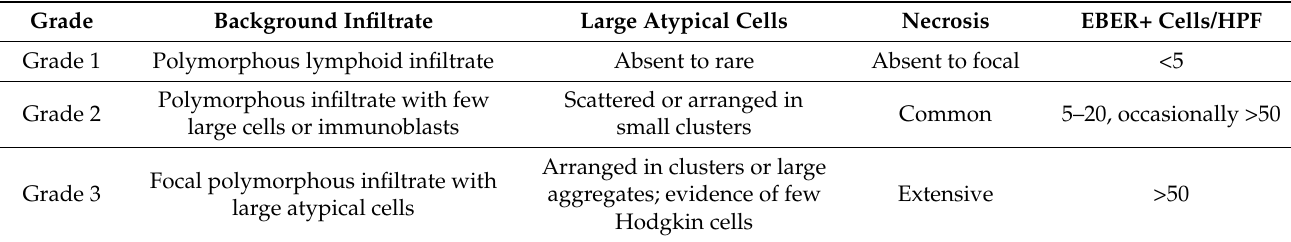
Figure 4. Lymphomatoid granulomatosis. ( A ). A number of atypical medium- to large- lymphoid cells within a polymor- phous infiltrate (H&E stain, 200 × ). ( B , C ). Neoplastic cells show diffuse and intense expression of CD20 in this case of grade 3 LYG, with fewer reactive CD3+ T-cells (( B ) CD20 immunostain, 200 × ; ( C ) CD3 immunostain, 200 × ). ( D , E ). Few cells show positivity for CD30 in another case of grade 2 LYG (CD30 immunostain, 400 × ); the same cells are intensely positive for EBER (EBER ISH, 400 × ). ( F ). Grade 3 LYG has a high proliferation index, i.e., >50% tumor cells showing nuclear immunoreactivity (Ki-67 immunostain, 400 × ). Table 2. Grading of lymphomatoid